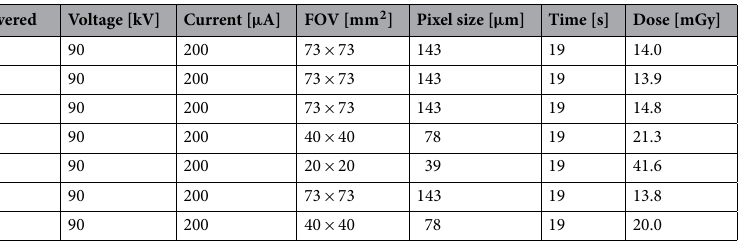
Table 3. Dose measurements for different settings. Measurements taken with wrapping the probe with a layer of 1cm meat to mimic scattering within a mouse are indicated by ’x’. Please note that a smaller FOV (smaller pixel size) is achieved by moving the X-ray source closer to the mouse/specimen which results in elevated dose levels.